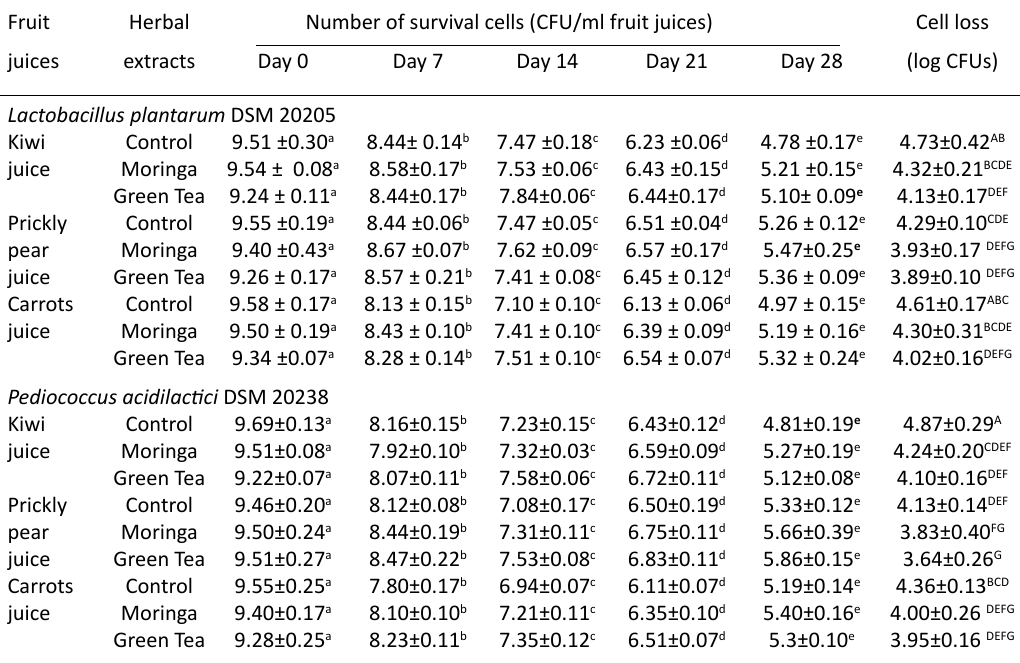
Table 3. Survivability of probiotics encapsulated with and without plant extracts in fruit juices during refrigerated storage Fruit Herbal Number of survival cells (CFU/ml fruit juices) Cell loss